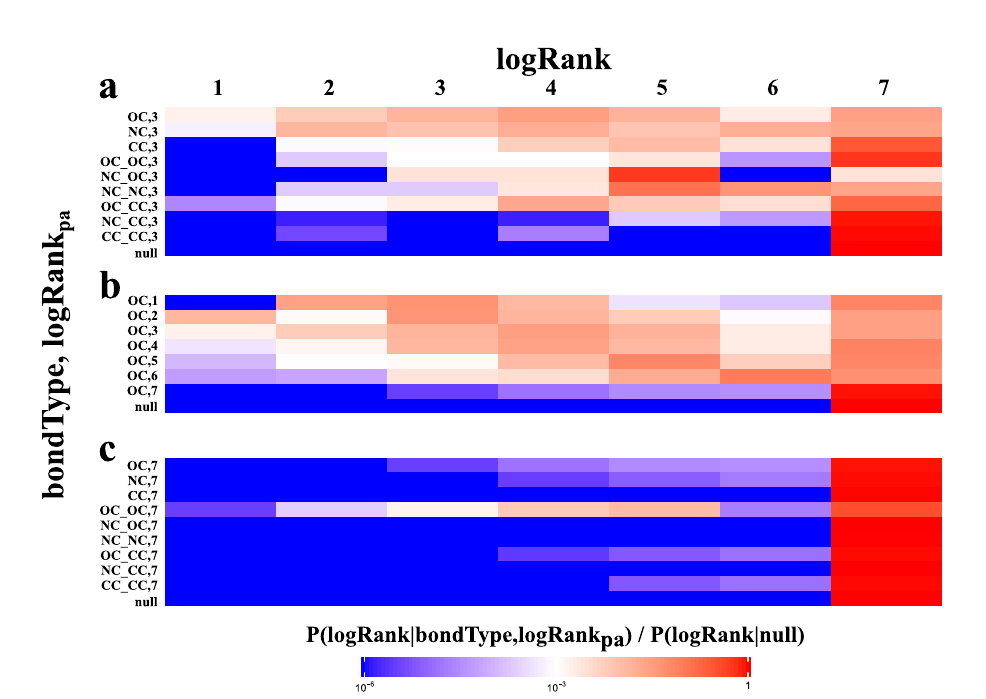
Fig. 2 Heatmap of P ( logRank ∣ bondType , logRank pa ). Each row represents bond type bondType and parent ’ s intensity rank logRank pa of a fragment. The row "null" refers to the null distribution P ( logRank ∣ null ). Each column represents the logRank of a child fragment. When logRank pa is 0, it means the parent is the root (precursor molecule). a logRank distribution over different bondType s for logRank pa = 3. b logRank distribution of OC bond over different logRank pa . Since there is only one fragment in the fragmentation graph that could have logRank = 1, the parent fragment of such fragment can not generate another fragment with logRank = 1, hence P (1 ∣ NC , 1) = 0. c logRank distribution over different bondType s for logRank pa = 7. Supplementary Figs. 2 and 3 show the complete heatmaps for charge + 1 and + 2,